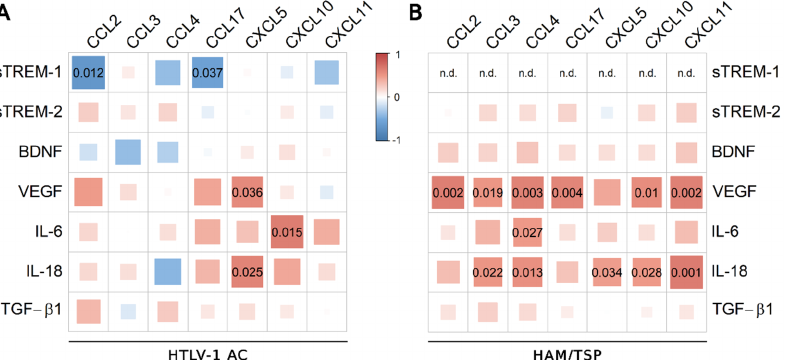
Figure 6. Correlation between CSF levels of inflammatory chemokines and factors associated with neuroinflammation. Correlation between CSF levels of TGF- β 1, IL-18, BDNF, VEGF, IL-6, sTREM- 2, sTREM-1, and chemokines (CCL2, CCL3, CCL4, CCL17, CXCL5, CXCL10, and CXCL11) was evaluated in ( A ) asymptomatic HTLV-1 carriers (AC) ( n = 13) and ( B ) HAM/TSP patients ( n = 20) with Spearman’s rank correlation test. Correlation coefficients are indicated by color intensity, in which positive correlations are shown in red and negative correlations in blue. The size of the squares at intersections between factors represents the p -value, which is shown only for significant associations ( p < 0.05).